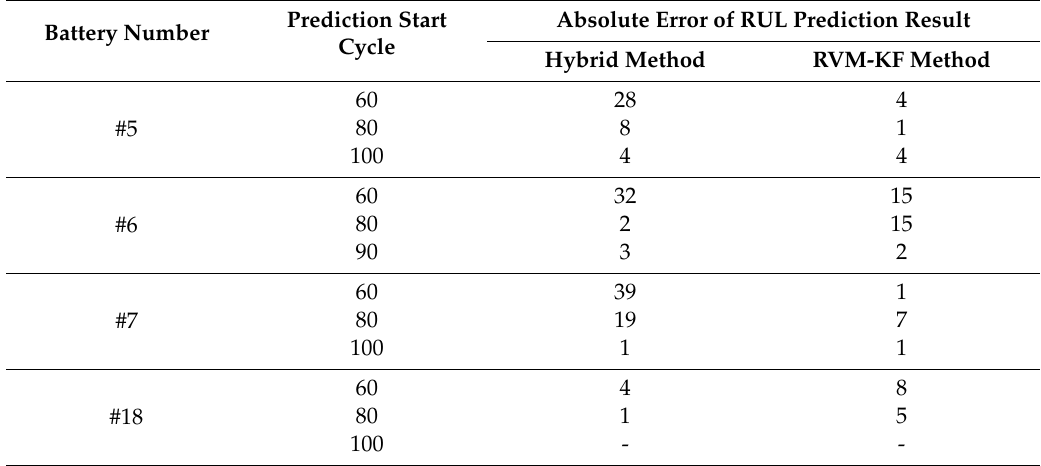
Table 2. Comparison of prediction results of the hybrid RVM-GM method with